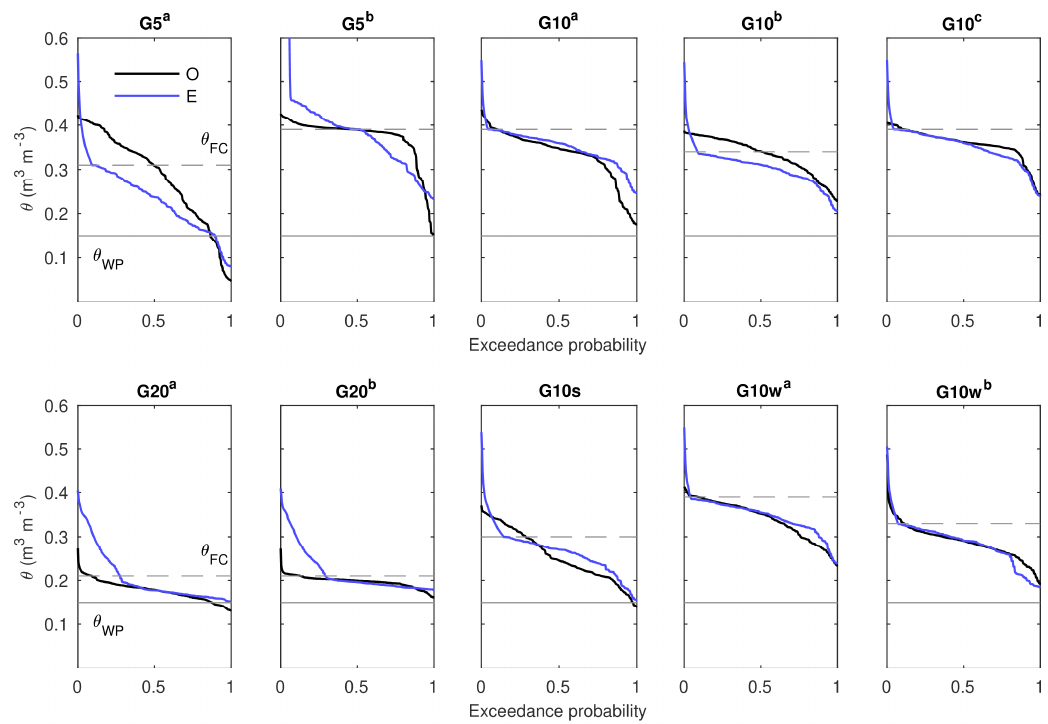
Figure 6. Observed (O) (black lines) and estimated (E) (blue lines) soil water content duration curve for each specimen during the rainy season 2015.